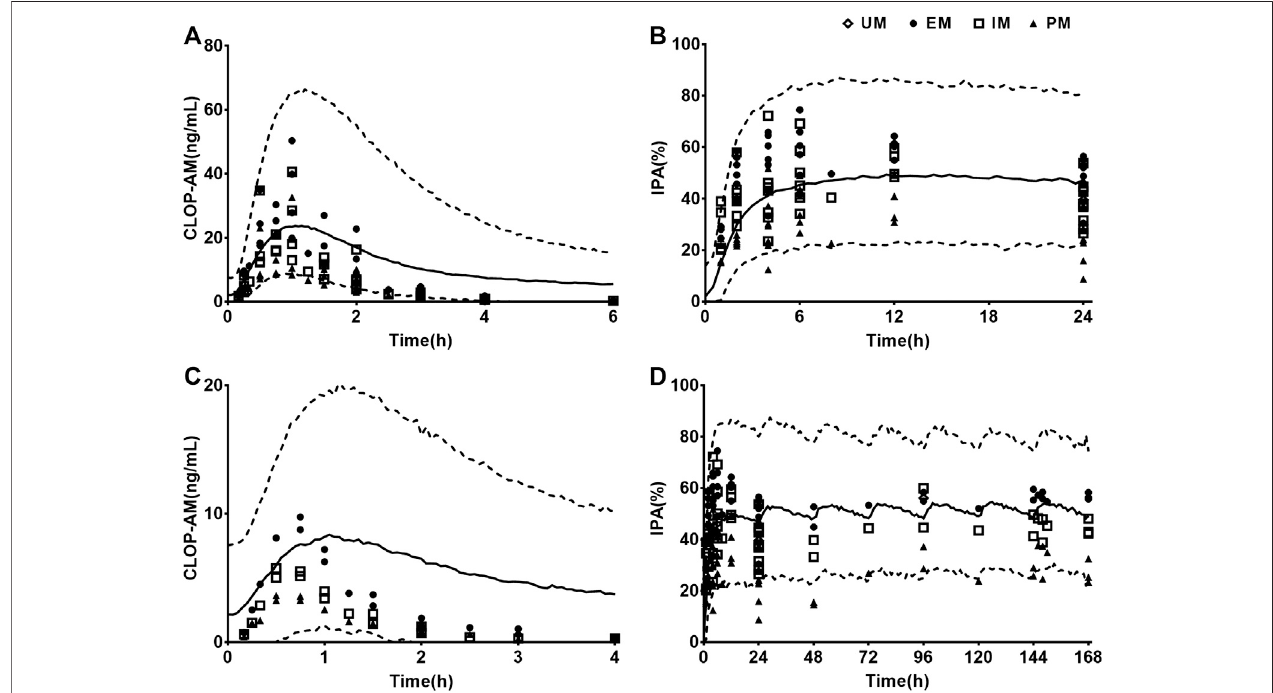
FIGURE6| Results ofvisualpredictive checks.VisualpredictivechecksofthepredictedconcentrationsofCLOP-AMand IPAfollowing300 mgoralsingledoseof CLOP (A,B) orloadingdose300 mgfollowedby75 mgmaintenancedose (C,D) ofCLOPtohealthyindividuals.TheobservationswerecitedfromHorenstein(EM n (cid:1) 6, IM n (cid:1) 6, PM n (cid:1) 6) (Horenstein et al., 2014), Kelly (EM n (cid:1) 34, IM n (cid:1) 38, PM n (cid:1) 11) (Kelly et al., 2012), Kim (2008, EM n (cid:1) 8, IM n (cid:1) 8, PM n (cid:1) 8) (Kim et al., 2008), Kim (2014,EM n (cid:1) 7,IM n (cid:1) 8,PM n (cid:1) 7forpharmacokinetics;EM n (cid:1) 33,IM n (cid:1) 37,PM n (cid:1) 32forpharmacodynamics)(Kimetal.,2014),Kim(2016,EM n (cid:1) 9,IM n (cid:1) 9, PM n (cid:1) 9) (Kim et al., 2016), Kobayashi (EM n (cid:1) 9, IM n (cid:1) 9, PM n (cid:1) 9) (Kobayashi et al., 2015), Song (EM n (cid:1) 8, IM n (cid:1) 10, PM n (cid:1) 2) (Song et al., 2018), Umemura (EM n (cid:1) 8, IM n (cid:1) 21, PM n (cid:1) 7) (Umemura and Iwaki, 2016), Zhang (EM n (cid:1) 16, IM n (cid:1) 16, PM n (cid:1) 16) (Zhang et al., 2020), Tazaki (EM n (cid:1) 13, IM n (cid:1) 10, PM n (cid:1) 4) (Tazaki et al., 2012), Simon (UM n (cid:1) 10, EM n (cid:1) 10, IM n (cid:1) 10, PM n (cid:1) 10) (Simon et al., 2011) and Nakkam (EM n (cid:1) 13, IM n (cid:1) 18, PM n (cid:1) 4) (Nakkam et al.,